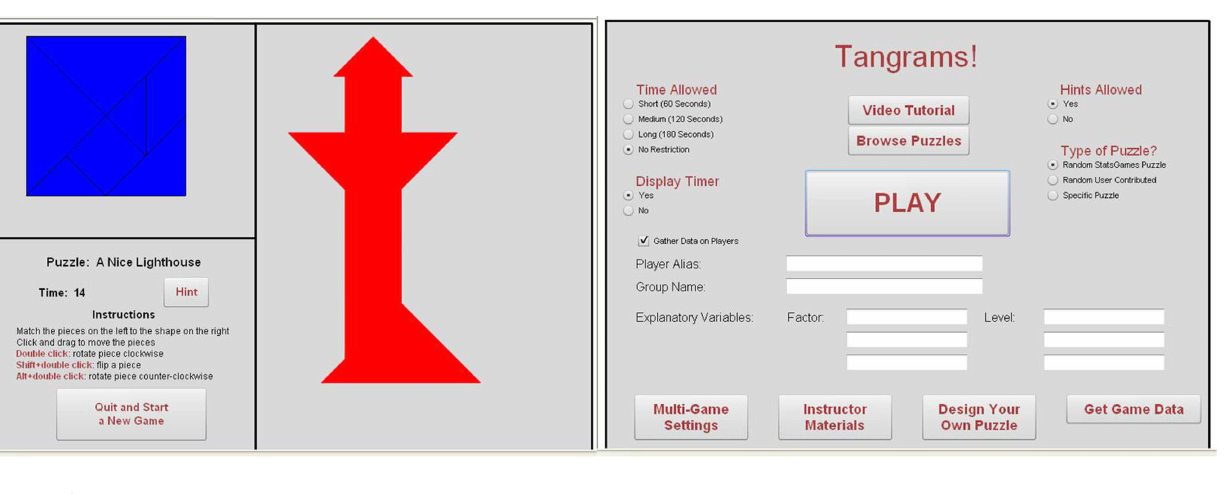
FIGURE 1 |Tangrams web